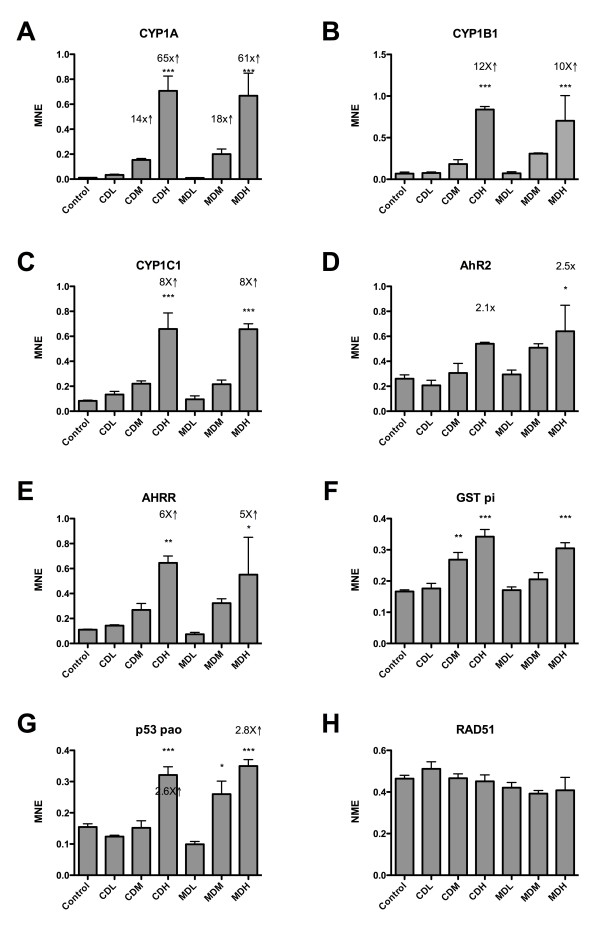
Transcriptional levels of a selected number of genes analyzed with RT-qPCR.A) CYP1A, B) CYP1B1, C) CYP1C1, D) AHR2, E) AHRR, F) GST π, G) p53, and H) RAD51. All groups n = 4 except MDM and MDH n = 3. MNE = mean normalized expression. The raw Ct values were transformed to quantities and PCR efficiency corrected according to the geNorm manual, and divided by the normalization factor calculated from four reference genes by geNorm. Arrows and numerals show fold changes. * P<0.05, **P<0.01. ***P<0.001.